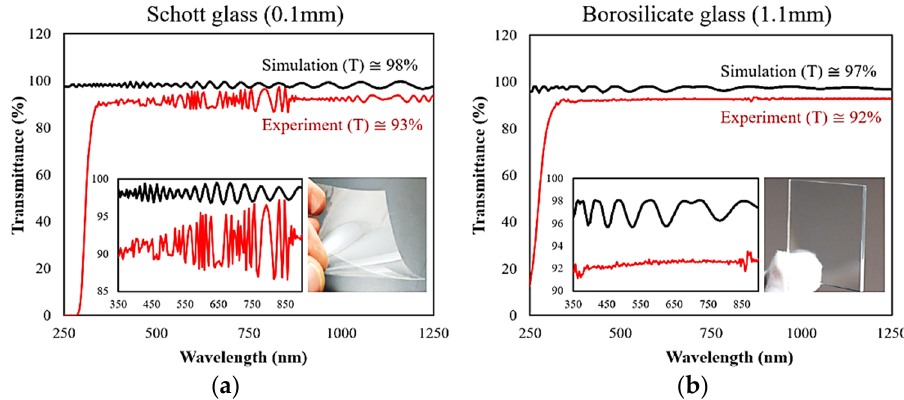
Figure 4. Transmittance results for both experimental and simulated materials; ( a ) ultra-thin, ( b ) borate glass.